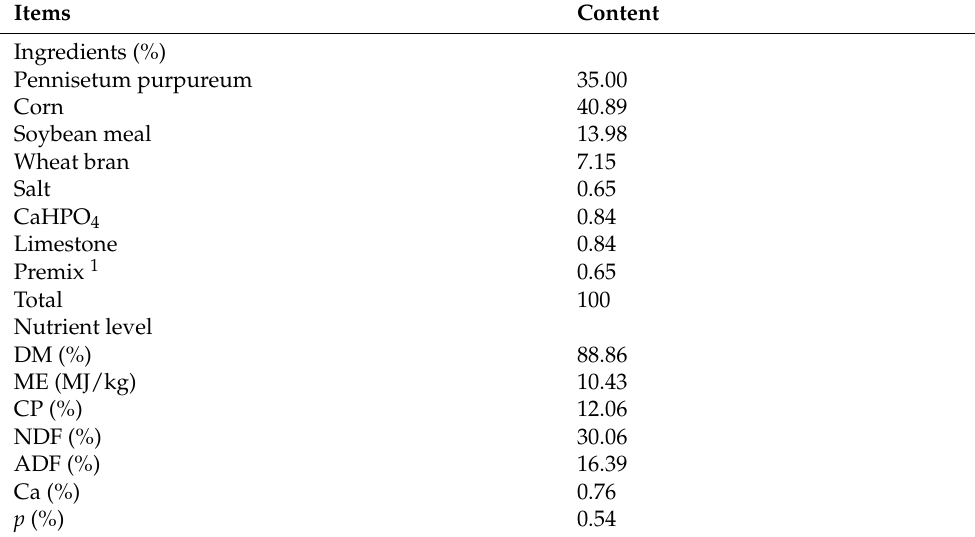
Table 1. The composition and level of basal diet (air-dry